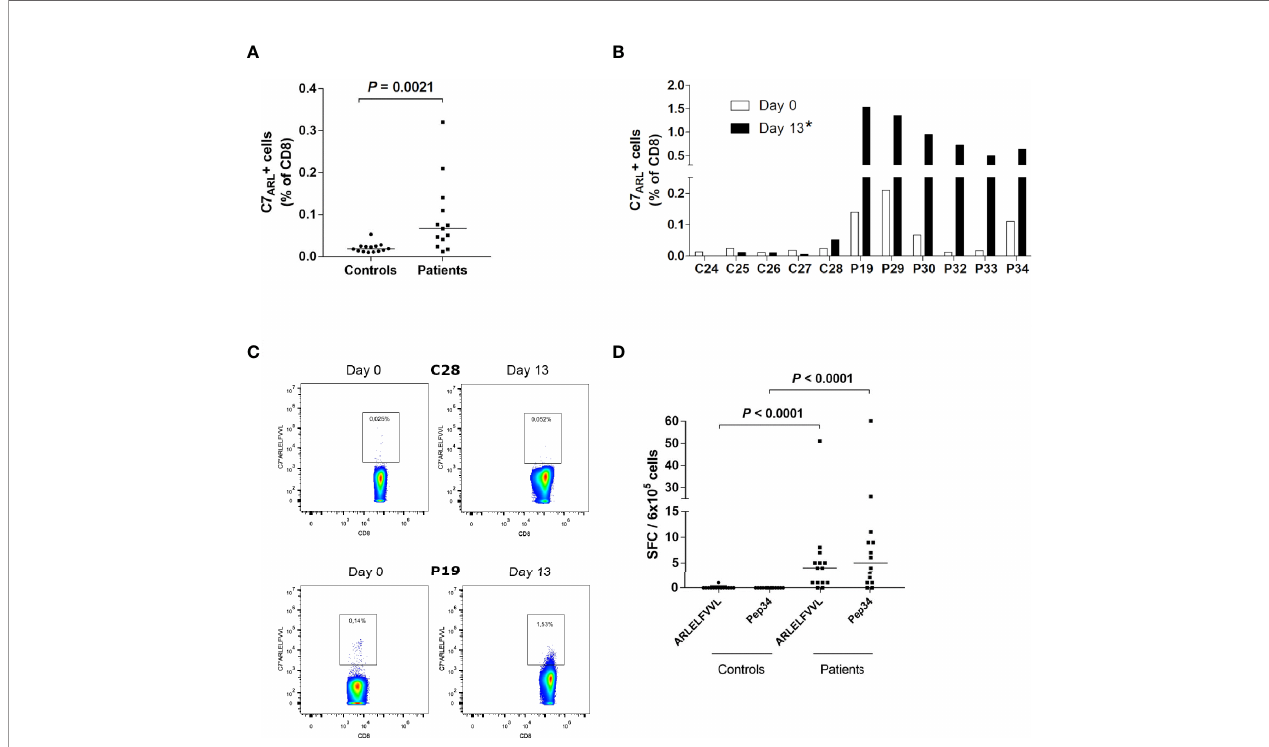
FIGURE 4 | IFN g producing ARLELFVVL-speci fi c CD8+ T cells are enriched in AAD patients. (A) PBMCs from HLA-C7-positive AAD patients (n = 13) and controls (n = 14) were stained with C7*ARLELFVVL streptamers ex vivo and analyzed with fl ow cytometry. (B) PBMC from HLA-C7-positive AAD patients (n = 6) and controls (n = 5) were stimulated with ARLELFVVL peptide and expanded for 13 days in vitro , before being stained with C7*ARLELFVVL streptamers and analyzed with fl ow cytometry. The graphs (A, B) show the frequencies of streptamer-binding CD8+ T cells. (C) Examples of fl ow cytometry streptamer plots from HLA-C7 individuals (C28, P19) ex vivo and following expansion (day 13). A strict, fi xed gate was used to distinguish streptamer-positive from negative cells. Gate numbers represent the frequencies (percentage) of streptamer-positive cells among total CD8+ T cells. (D) PBMCs from AAD patients (n =14) and controls (n = 14) were stimulated with ARLELFVVL or Pep34 ex vivo to detect IFN g -SFCs. The amount was measured by ELISPOT and is expressed as SFCs per 6x10 5 PBMCs after background subtraction. Lines represent median values (A, D) . Statistical analyses were performed using Mann-Whitney U-test; P-values <0.05 are shown, * in (B) signi fi es a statistically signi fi cant difference of streptamer-positive cells between patients and controls on day 13 ( P =